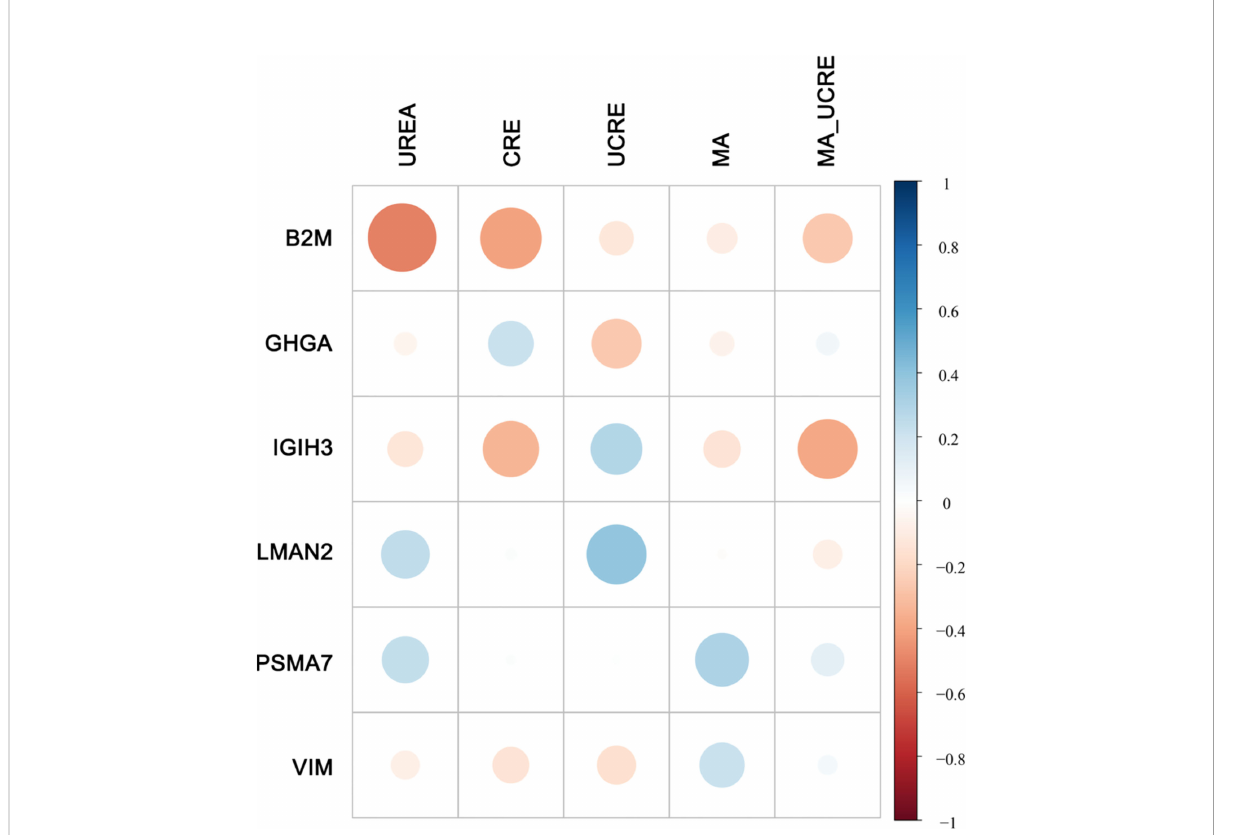
FIGURE 5 Correlation between DEPs and clinical features. Five clinical features related to DKD diagnosis are listed at the top. The DEPs with the highest number of correlations to the 5 clinical features are displayed on the left. The size of the dot represents the level of relevance. A blue dot represents a positive correlation between the two metrics, and a red dot indicates a negative correlation between the two